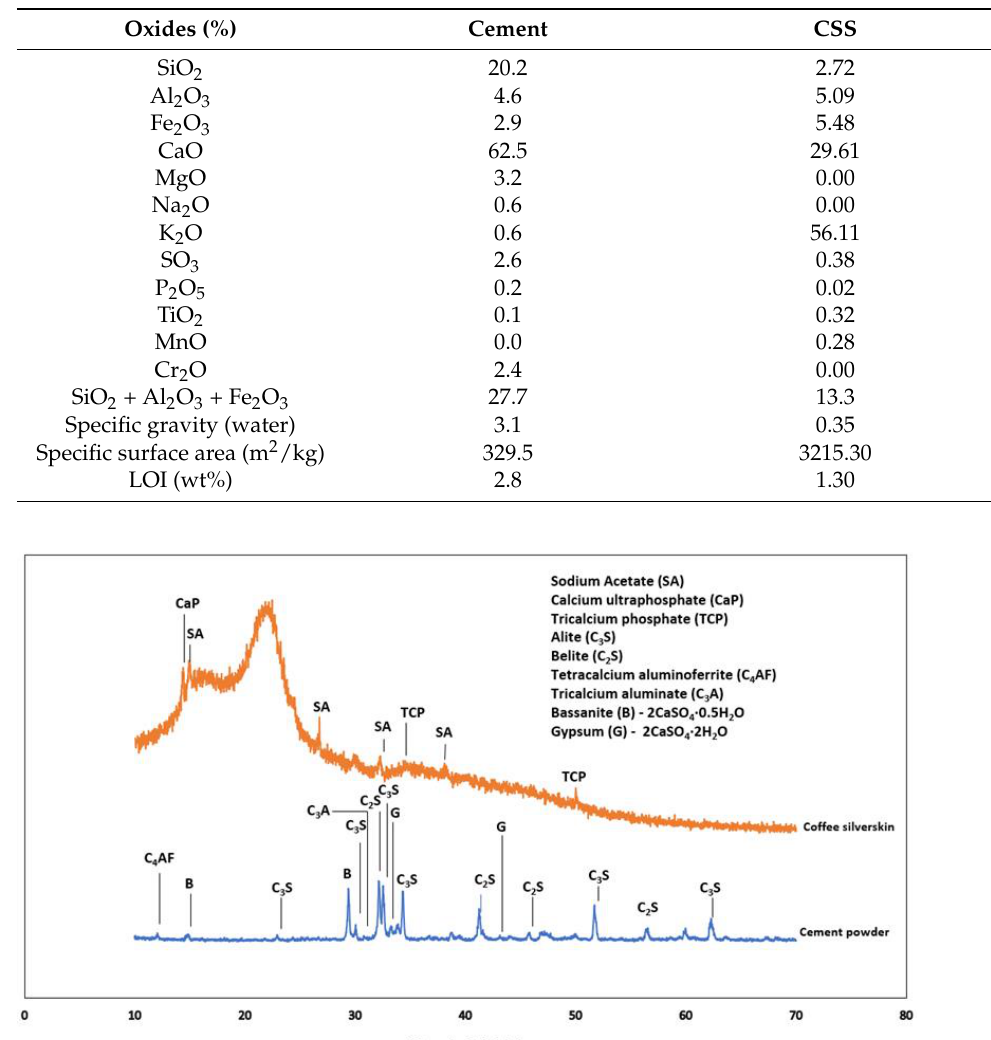
Table 1. Oxide composition of cement and coffee silver skin.